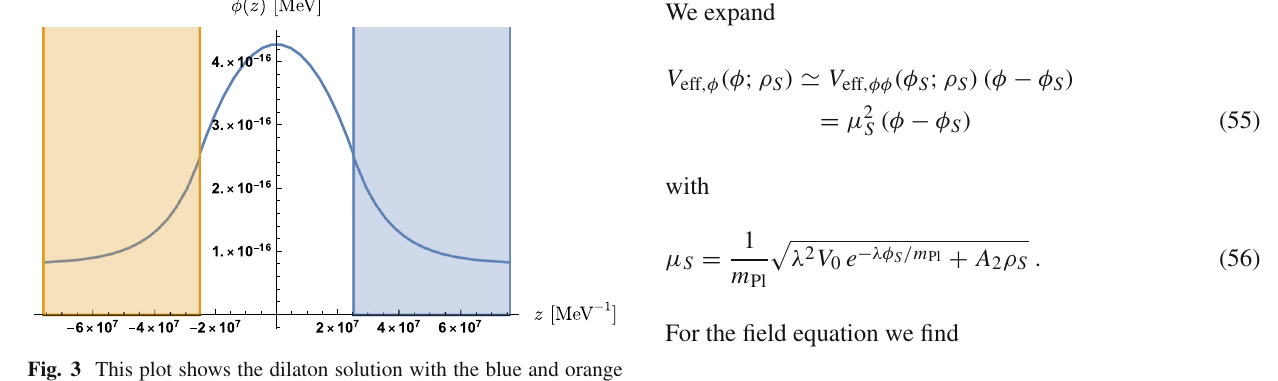
Fig. 3 This plot shows the dilaton solution with the blue and orange area depicting the mirrors of the experimental setup. We can see that λφ( z ) (cid:6) m = 1 . 22 × 10 22 MeV is indeed satisfied in this Pl